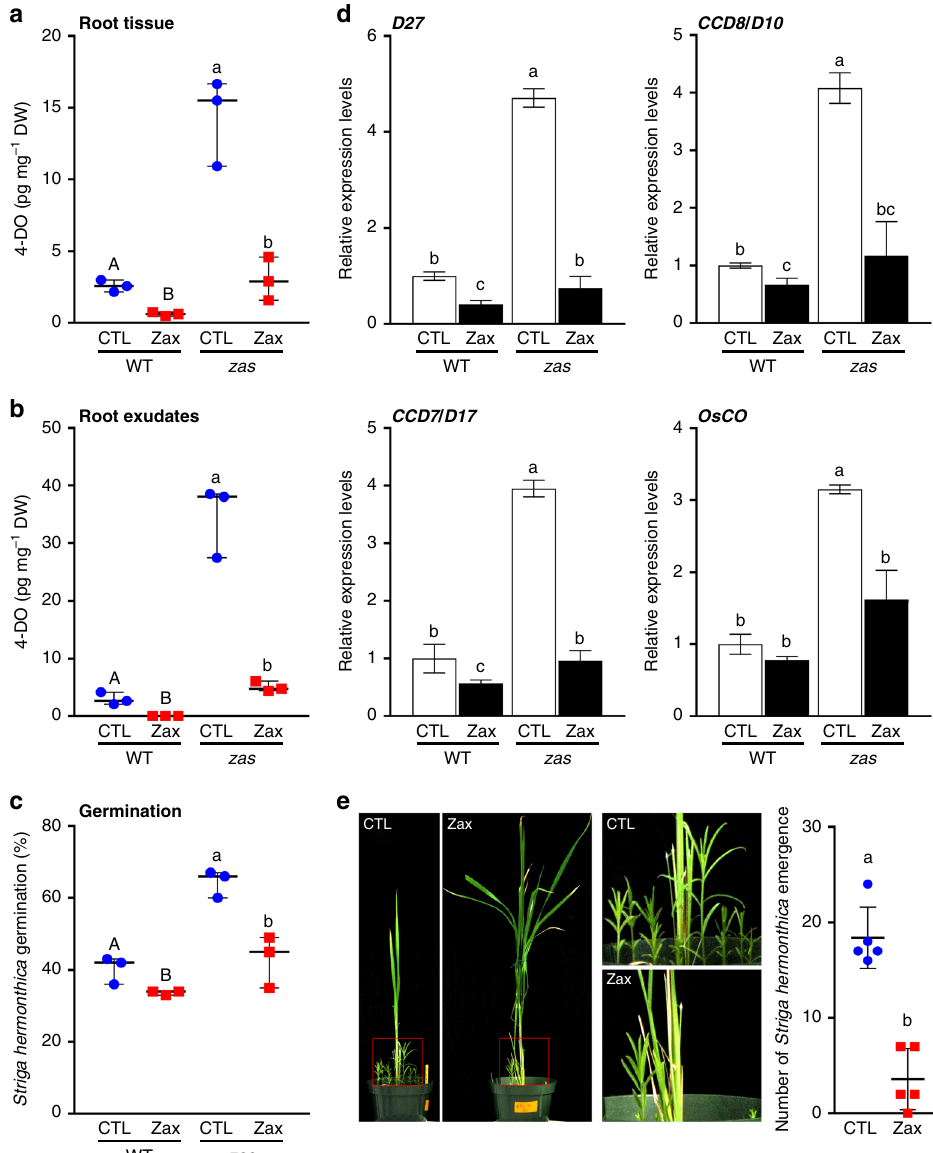
Fig. 3 Effect of zaxinone on rice SL biosynthesis and release. a, b SL, 4-deoxyorobanchol (4-DO), quanti fi cation in wild-type and zas mutant roots ( a ) and root exudates ( b ) in response to zaxinone (5 µ M) under Pi starvation. c Striga seeds germination rate upon treatment with exudates analyzed in b . d qRT- PCR analysis of transcript levels of SL biosynthesis genes (D27, CCD7, CCD8, and CO) transcript levels in root tissues analyzed in a . Transcript levels in wild-type control samples were normalized to 1. e Effect of zaxinone (10 µ M) on Striga infestation of 6-weeks old rice cv. IAC-165 plants in soil. Effect on rice and Striga growth (Left, picture). Number of emerging Striga plants (Right). Bars represent mean ± SD; a – d n = 3 biological replicates; e n = 5 biological replicates; statistical analysis was performed using one-way analysis of variance (ANOVA) and Tukey ’ s post hoc test. Different letters denote signi fi cant differences ( P < 0.05). CTL control, Zax